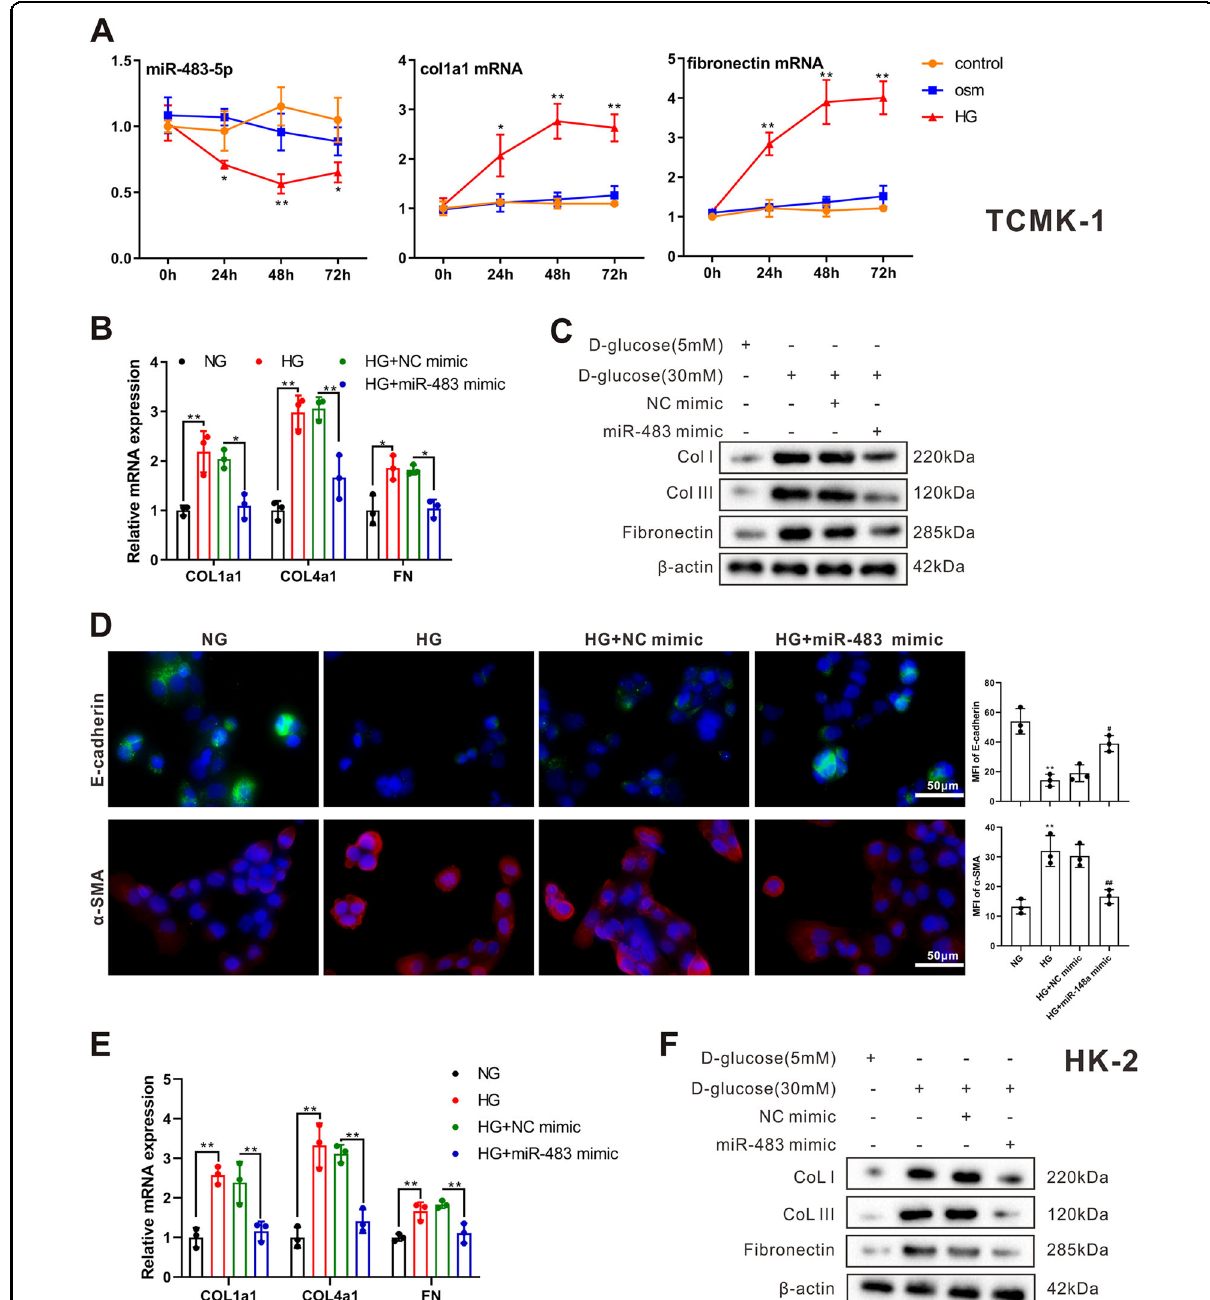
Fig. 2 Effect of miR-483-5p on the expressions of fi brosis-related genes in vitro. The in vitro diabetic model was induced by high glucose (HG). A Detection of miR-483-5p, Col1a1, and fi bronectin expressions by qRT-PCR at 0, 24, 48, and 72 h after the HG treatment. After transfecting miR-483- 5p mimic into renal tubular epithelial cells (TECs) TCMK-1, the cells were treated with 30 mM HG for 48 h. B Detection of Col1a1, Col4a1, and fi bronectin mRNA levels by qRT-PCR. C Detection of CoL I, CoL III, and fi bronectin protein levels by western blot. After transfecting miR-483-5p mimic into HK-2 cells, the cells were treated with 30 mM HG for 48 h. D Detection of E-cadherin and alpha-smooth muscle actin ( α -SMA) by immuno fl uorescence. E Detection of Col1a1, Col4a1, and fi bronectin mRNA levels by qRT-PCR. F Detection of CoL I, CoL III, and fi bronectin protein levels by western blot. * P < 0.05, ** P < 0.01 vs. control, NG or HG + NC mimic. # P < 0.05, ## P < 0.01 vs. HG + NC mimic. One-way ANOVA followed by Tukey ’ s post-test for multiple comparisons was applied for groups of three or more of three independent experiments. osm osmolarity, HG high glucose, NG normal glucose, FN fi bronectin.